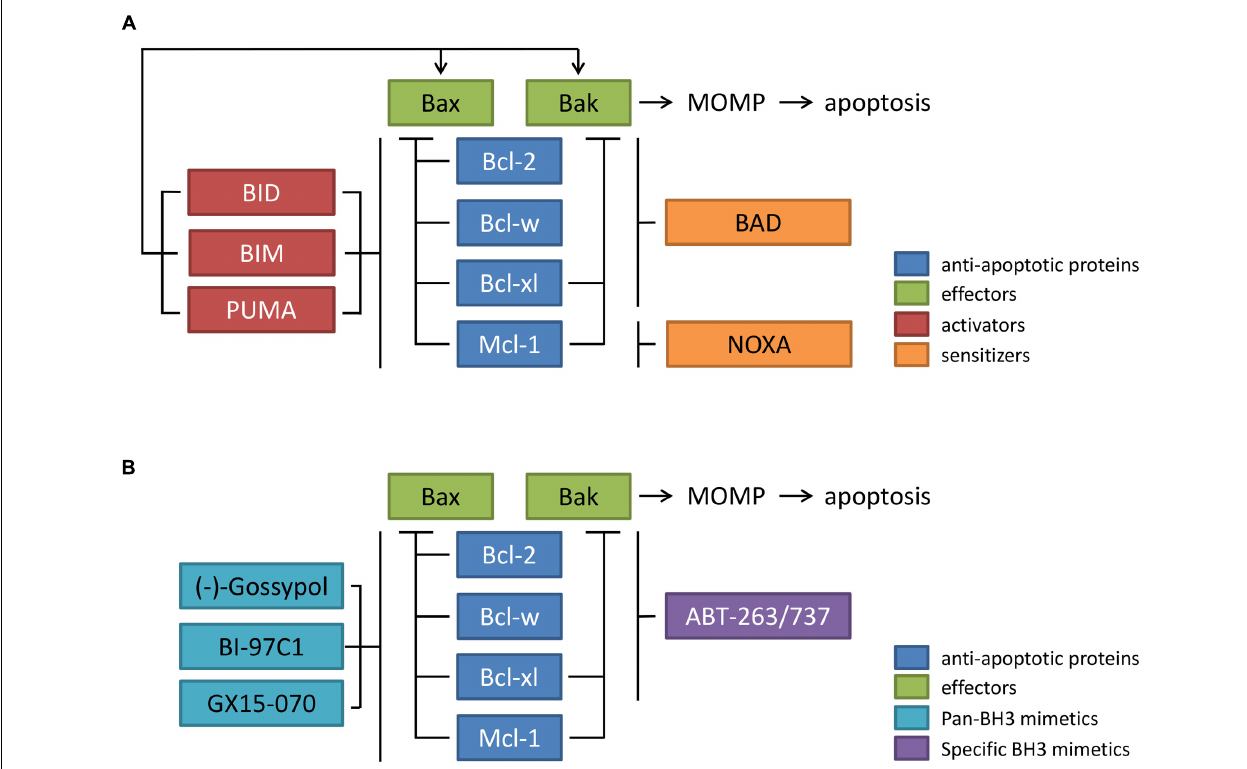
FIGURE 1 | Schematic representation of the interactions between different members of the Bcl-2 protein family and BH3 mimetics. (A) The effector proteins of the Bcl-2 family, Bax and Bak, are inhibited by the anti-apoptotic proteins Bcl-2, Bcl-w, Bcl-xl, and Mcl-1. Upon induction of apoptosis, the sensitizers BAD and NOXA inhibit the anti-apoptotic proteins. The activators BID, BIM, and PUMA can also block the anti-apoptotic proteins and can interact directly with Bax and Bak. Free effectors can then induce MOMP and apoptosis. (B) The BH3 mimetics are surrogate proteins to the activator and sensitizer BH3-only proteins. They can be divided into pan-BH3 mimetics [GX15-070, (–)-gossypol, BI-97CI] antagonizing all members of the anti-apoptotic proteins, and specific BH3 mimetics (ABT-263/737), binding to Bcl-2, Bcl-xl, and Bcl-w, but not Mcl-1. Abbreviations: BAD, Bcl-2 antagonist of cell death; Bak, Bcl-2 antagonist/killer; Bax, Bcl-2 associated X protein; Bcl-2, B-cell lymphoma 2; Bcl-w, Bcl-2 like 2; Bcl-xl, B-cell lymphoma extra-large; BID, BH3 interacting domain death agonist; BIM, Bcl-2 interacting mediator of cell death; Mcl-1, myeloid cell leukemia sequence; MOMP, mitochondrial outer membrane permeabilization; NOXA, phorbol-12-myristate-13-acetate-induced protein 1; PUMA, p53 upregulated modulator of apoptosis. BH3 mimetics: ABT-263, Navitoclax; BI-97-CI, Sabutoclax; GX15-070,